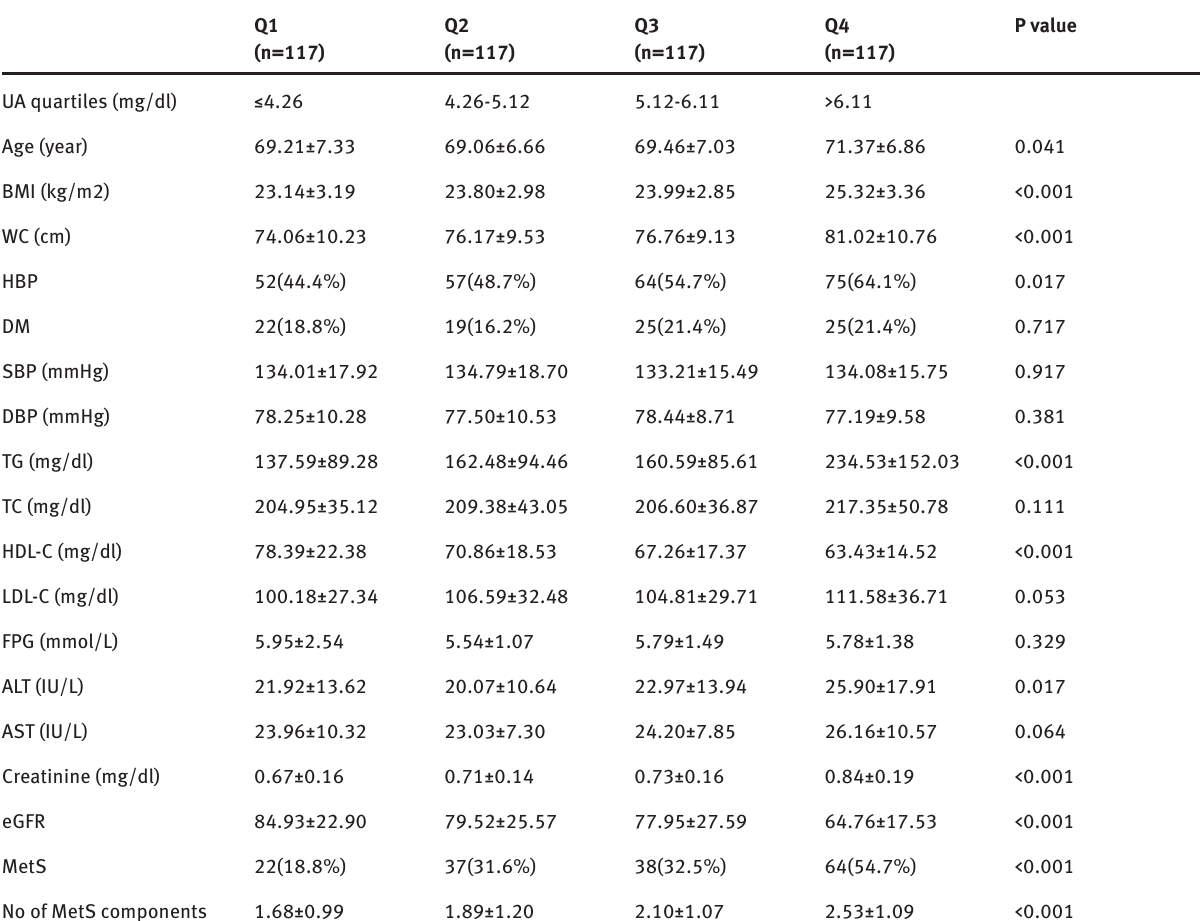
Table 2: Characteristics of subjects according to quartiles of